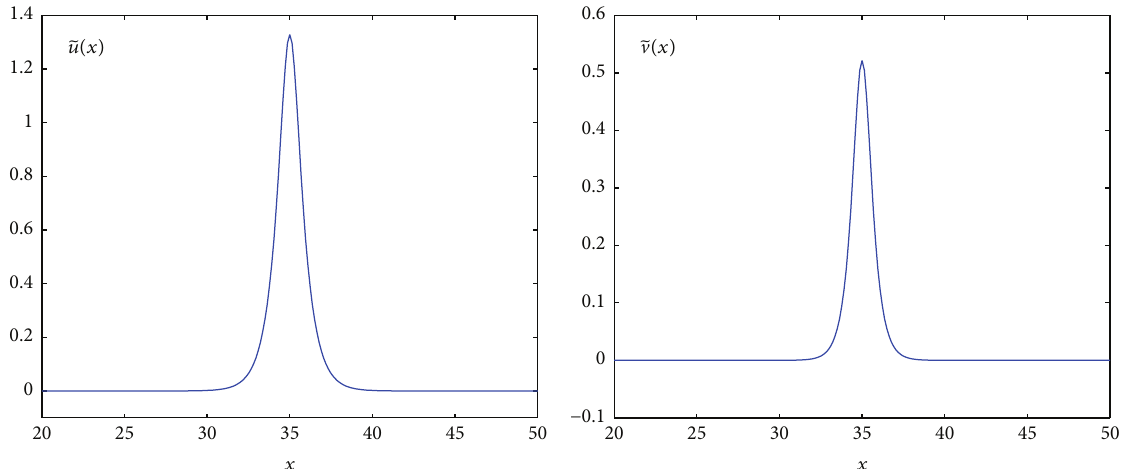
Figure 3: Vector soliton of system (1) obtained after 10 Newton’s iterations and 𝛿 = 0 , 𝜎 1 = 0.5 , 𝜎 2 = −0.5 , 𝛼 = 1.5 , and 𝐾 = 0.5 .